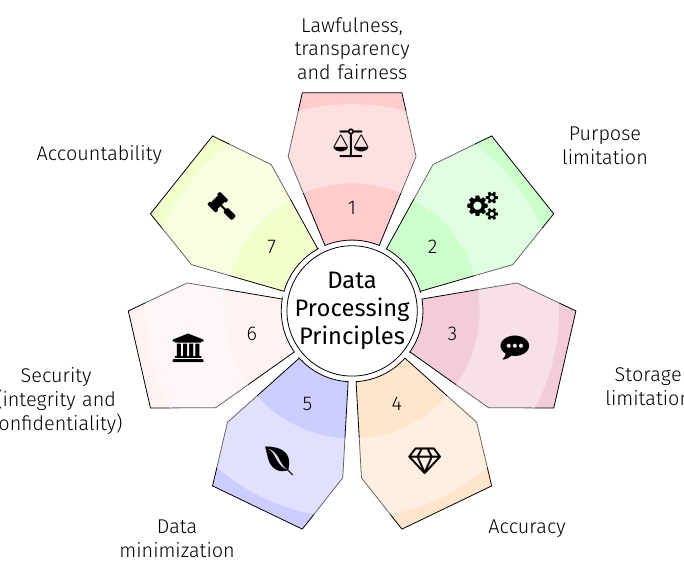
Figure 2. Data processing principles